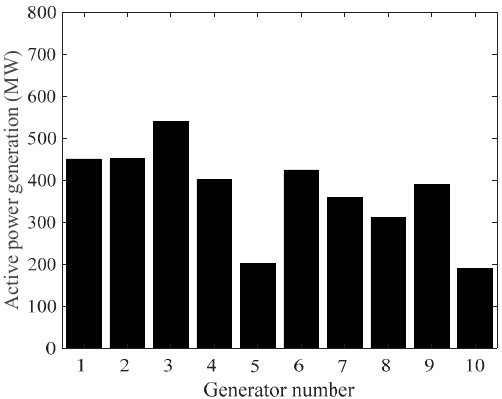
Figure 2. The initial active generation of the conventional generators.